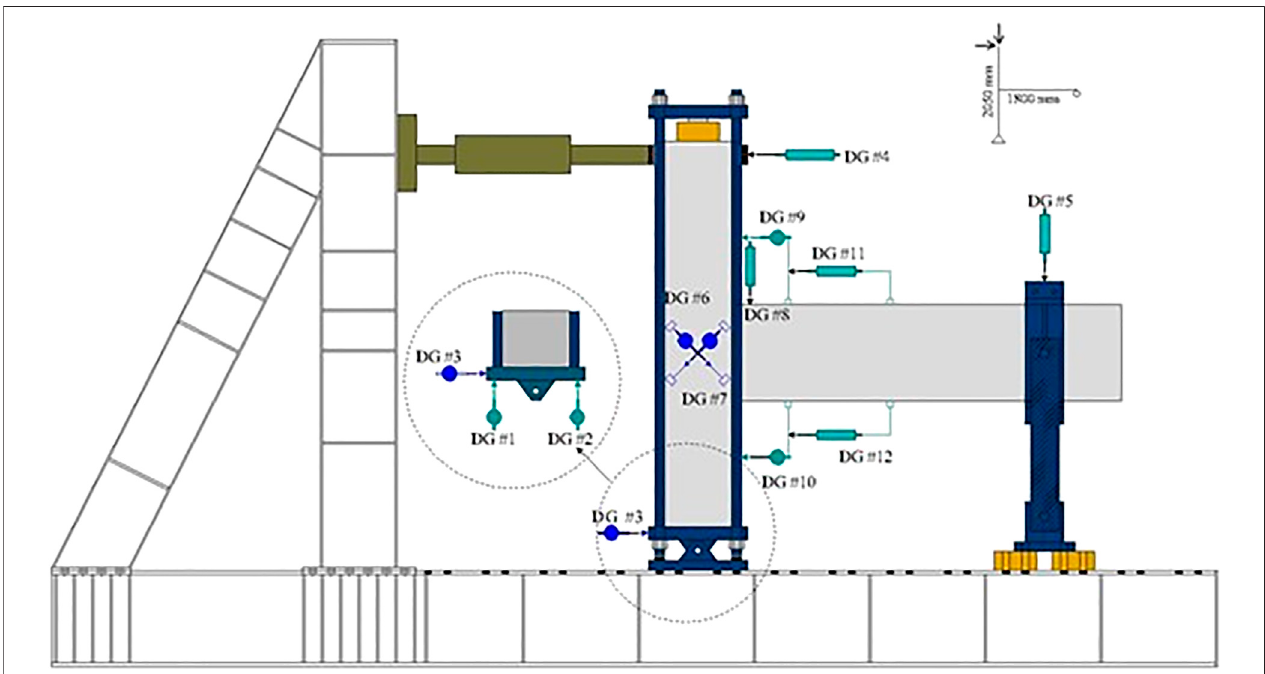
FIGURE 4 | Test setup and